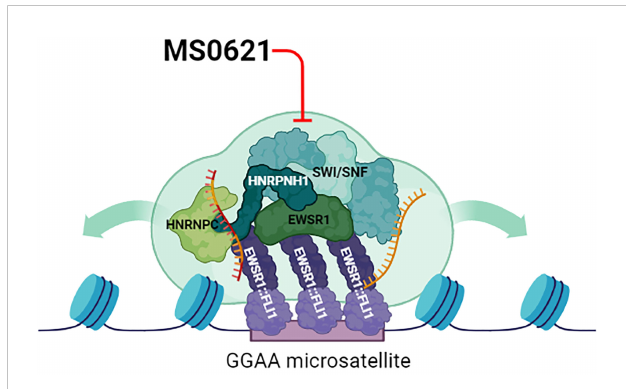
FIGURE 6 Proposed Model of Perturbation of MS0621. The chromatin landscape at EWSR1::FLI1 targeted sites is likely established and maintained through the activity of SWI/SNF as well as through biophysical properties such as phase separation mediated by proteins and RNA (gold RNA molecule). Likewise, EWSR1::FLI1 alters the function of RNA binding proteins to program Ewing sarcoma-speci fi c alternative patterns (gold and red RNA molecule). EWSR1::FLI1 may depend on the complex to mediate its roles in chromatin and transcription, but this dependence may also represent a vulnerability for Ewing sarcoma cells. MS0621 interacts with and may perturb the complex and inhibit the functions required by EWSR1::FLI1 leading to altered chromatin organization, gene expression, and splicing programs. Thus, perturbation of these functions likely contributes to the cell proliferation defects and cell cycle arrest observed in Ewing sarcoma cell lines upon MS0621 treatment. Created with